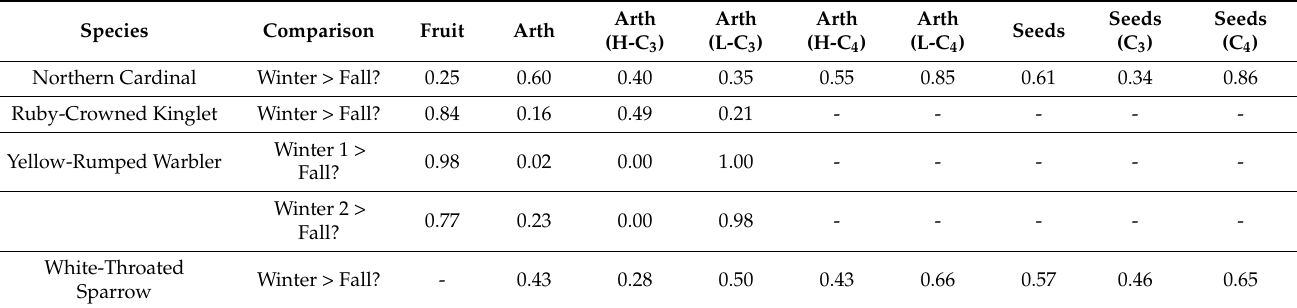
Table 1. Species-specific probabilities that dietary endpoints differ among seasons. Probabilities above 0.5 indicate support for the one-sided comparisons (e.g., winter fruit > fall fruit) whereas probabilities below 0.5 indicate support in the other direction (e.g., fall fruit > winter fruit). Dashes indicate that contributions of those dietary endpoints were not estimated for that species-season combination. Abbreviations: Arth = arthropod; H-C 3 = high-trophic C 3 arthropods; L-C 3 = low-trophic C 3 arthropods, etc. Winter samples were pooled across years for all species except the Yellow-Rumped Warbler, for which there was sufficient sample size to estimate the two years separately (winter 1 refers to 1998/1999 and winter 2 refers to